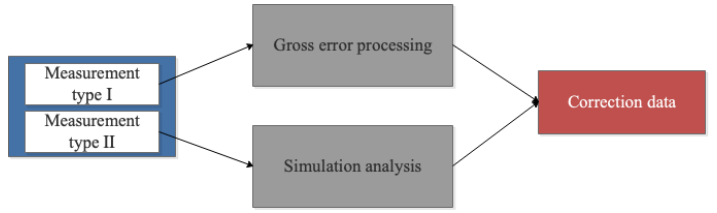
Figure 5. Measurement data correction.